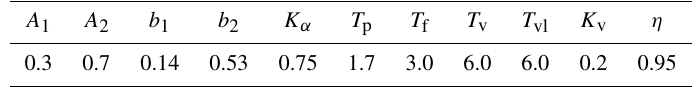
Table 2. Constants applied for the Leishman–Beddoes model.